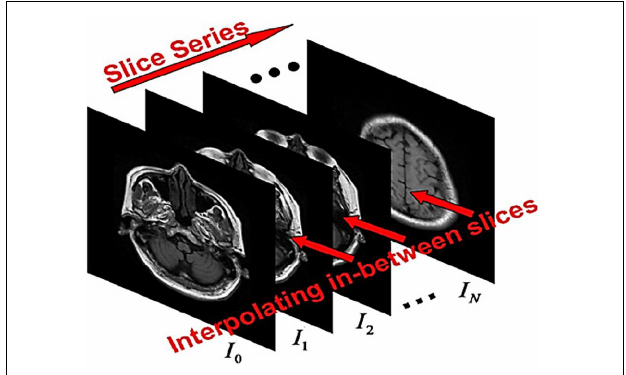
FIGURE 1 | The sequence of cross-sections to create a three-dimensional